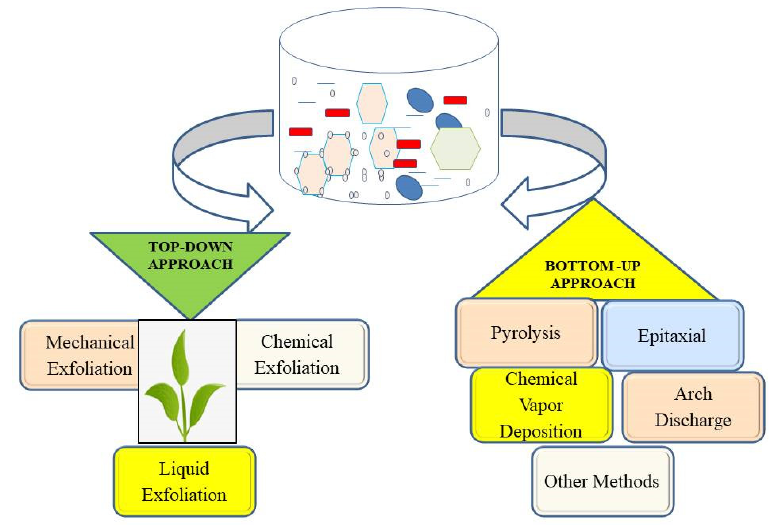
Figure 4. Synthesis methods for GN-based nanomaterials.